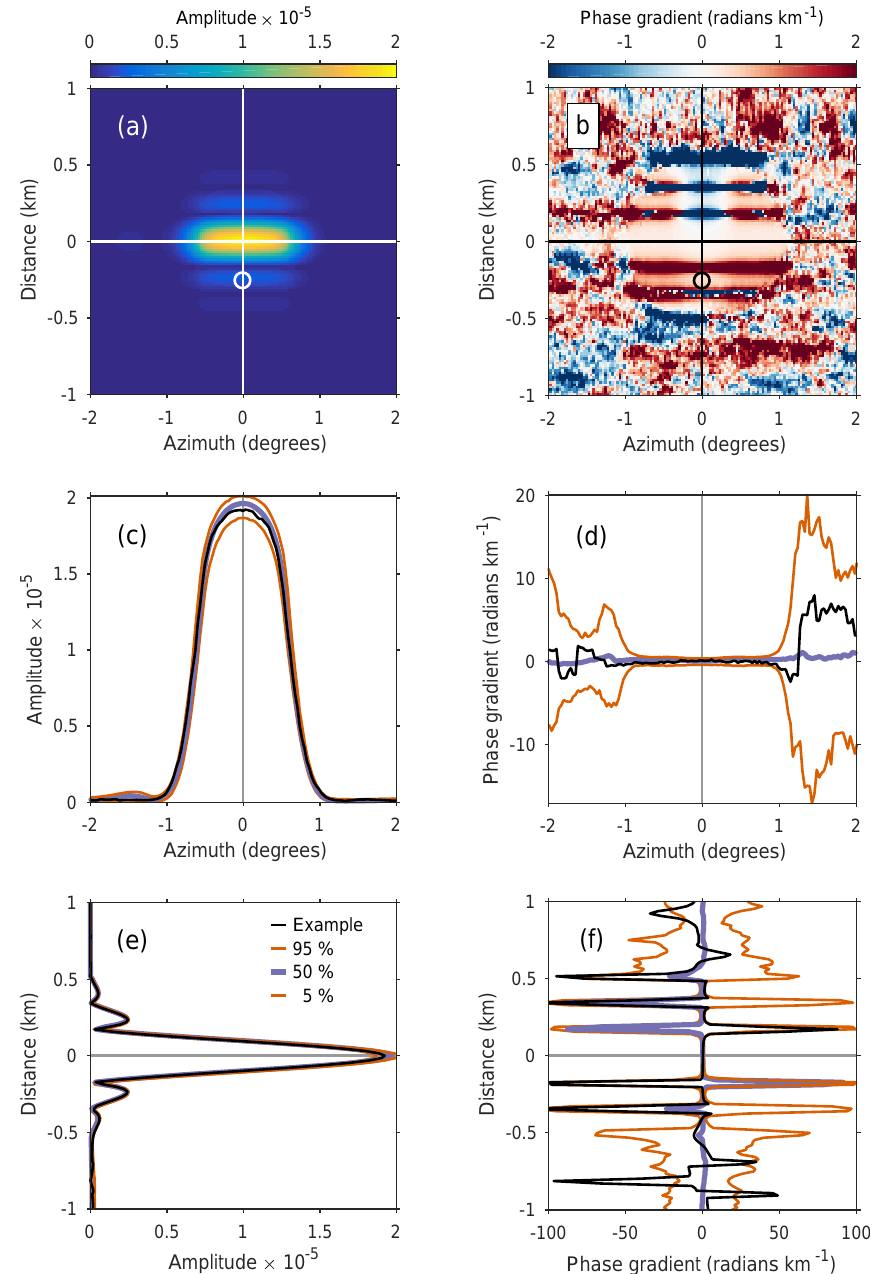
Figure 2. Impact of a mast on weather radar I/Q data, recorded by Vara during September 2016. Panel (a) shows the average I/Q amplitude near the position of the mast, while panel (b) shows the average phase gradient. The position of the mast is marked by a black or white circle. Black and white vertical and horizontal lines indicate from where data in panels (c) to (f) originate. Panels (c) and (d) show the 5th, 50th and 95th percentiles of the amplitude and phase gradient, respectively, as functions of azimuth. Panels (e) and (f) show the 5th, 50th and 95th percentiles of the amplitude and phase gradient, respectively, as functions of distance. Black lines in panels (c) to (f) show example data from a single